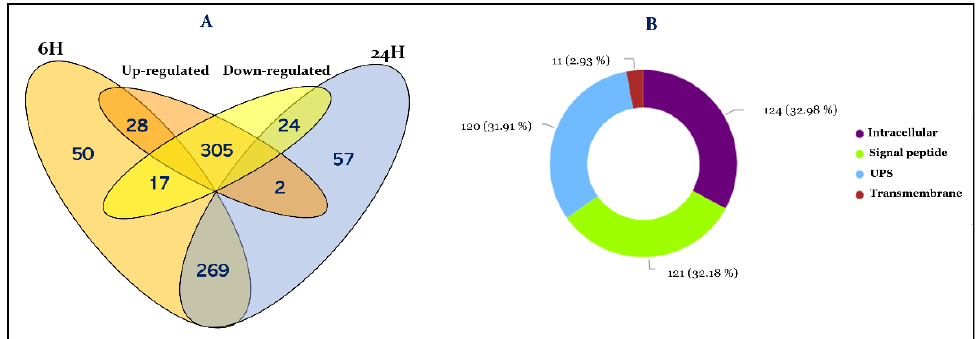
Figure 1. ( A ) Venn diagram showing the distribution of the identified proteins of the hemolymph at 6 h and 24 h post-infection. Intersections display protein expression specificity to each condition (Table S1); ( B ) Representation of the distribution of total hemolymph proteome between intracellular and extracellular proteins. Extracellular proteins are recognized using OutCyte prediction tool either by the presence of a predicted signal peptide using the SignalP algorithm, transmembrane or potential unconventional protein secretions (UPS) from intracellular proteins. Numbers in brackets indicate the percentage of proteins in each category.